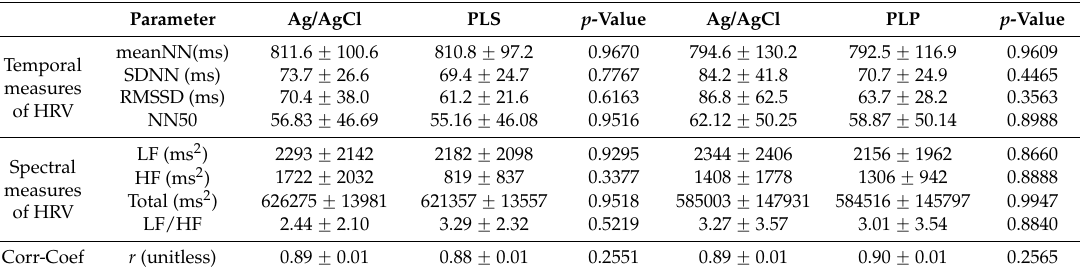
Table 5. Electrocardiogram signal quality—freshwater wet